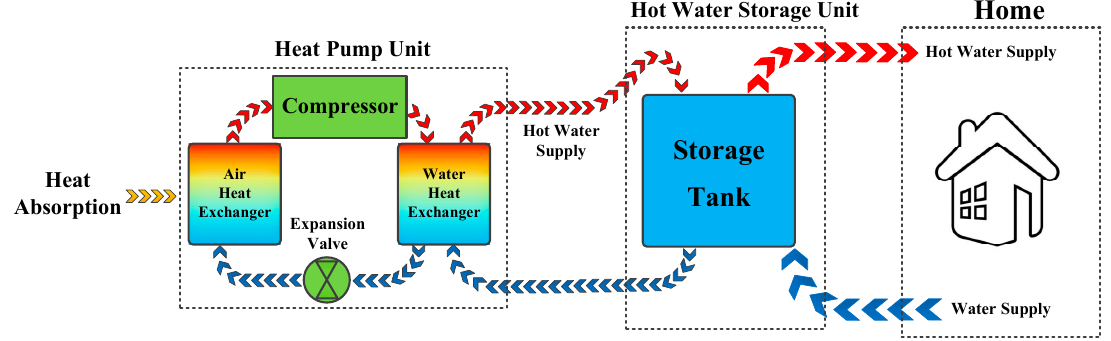
Figure 1. Heat pump water heater schematic diagram.